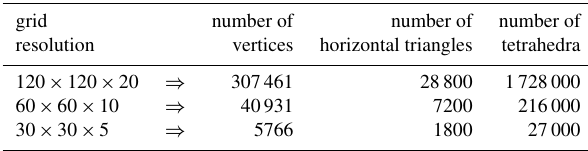
Table 5. Data corresponding to the three tetrahedral meshes used in the ice sheet experiment. grid number